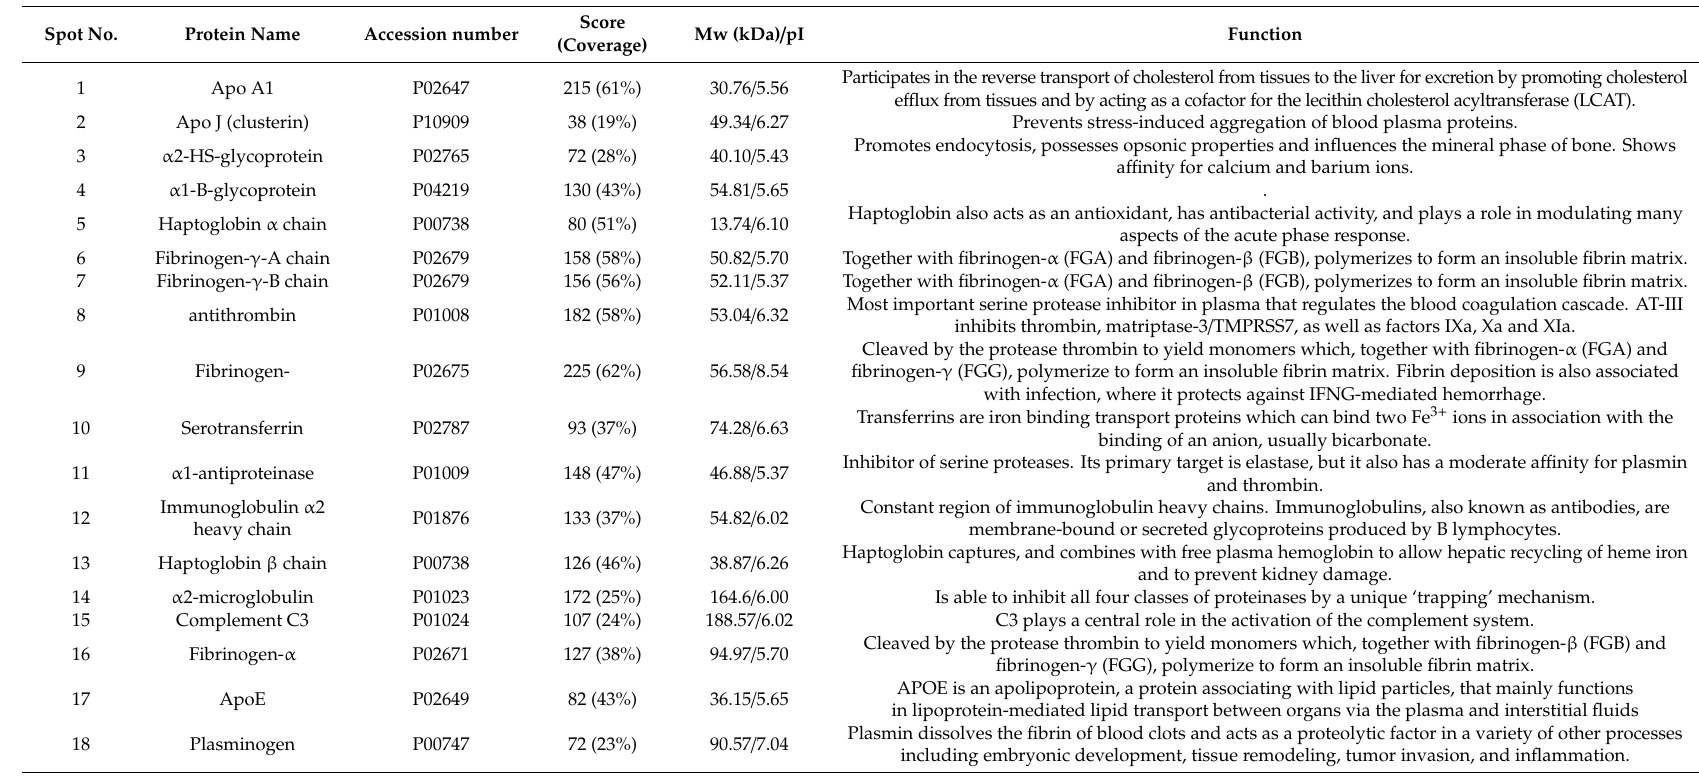
Table 1. List of identified protein